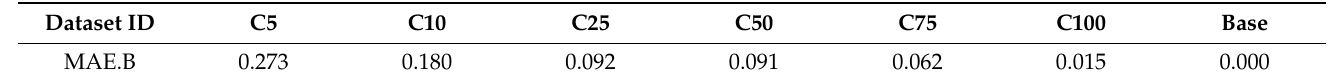
Table 4. Aggregated performance comparison of buffer sizes over different clusters of the annual